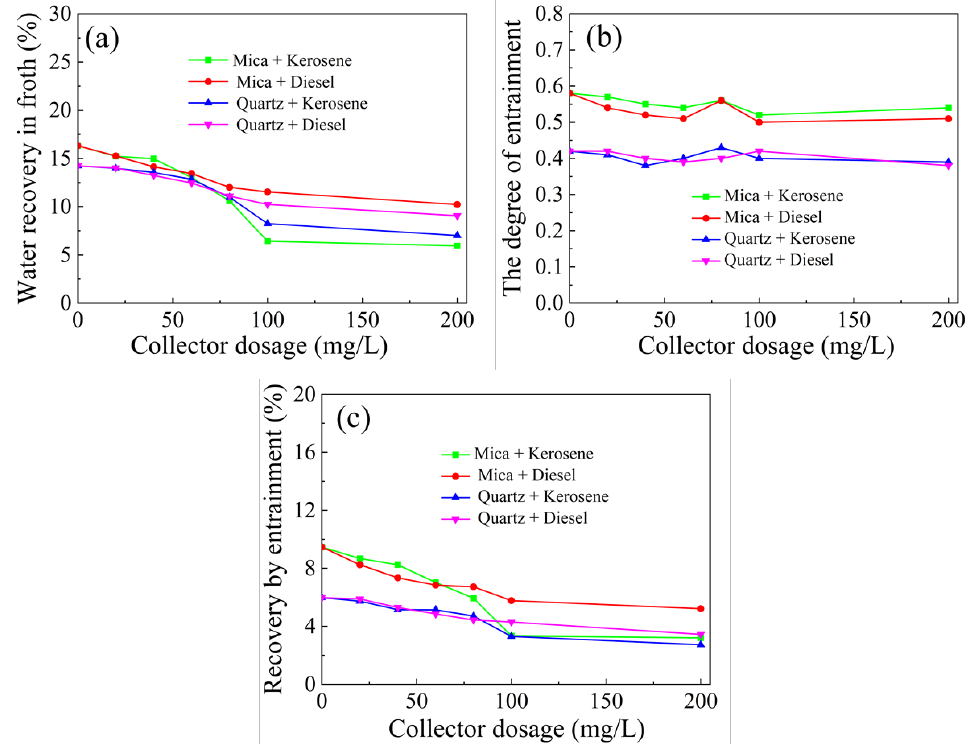
Figure 9. The effect of collectors on the entrainment of gangue mineral flotation: ( a ) the water recovery in froth; ( b ) the degree of entrainment; and ( c ) the recovery of gangue by entrainment.